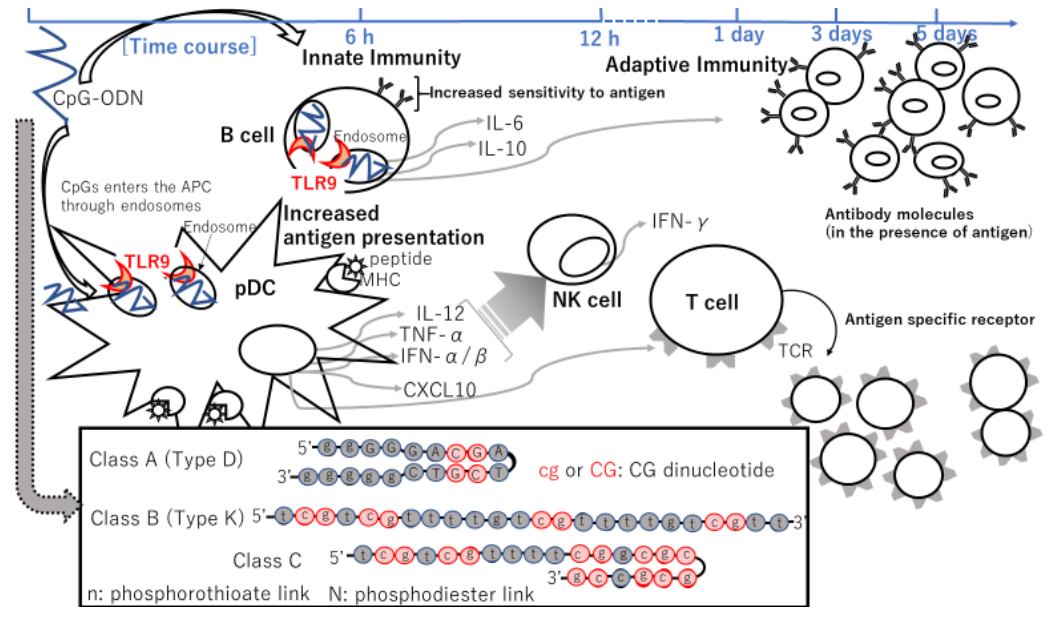
Figure 3. CpG-ODN cellular mechanism of action. DNA containing one or more CpG motifs is taken up by endocytosis in most cell types, but only activates cells expressing the TLR9 receptor (B cells and pDC in humans). These cells create a T H 1-like cytokine milieu by secreting IFN- α / β , IL-12, CXCL10, and other Th1-promoting cytokines and chemokines. NK cells are secondarily activated, secreting IFN- γ and gaining lytic activity. In addition, B cells become more sensitive to activation through their antigen receptors, and both B cells and pDCs have enhanced expression of costimulatory molecules, improving their ability to activate T-cell responses. Class A (also called Type D) ODNs have a phosphodiester core flanked by phosphorothioate terminal nucleotides (in box ). They carry a single CpG (indicated in red circles) motif flanked by a palindromic sequence that enables the formation of a stem-loop structure. Class A ODN also possesses poly G motifs at the 3 ′ and 5 ′ ends that promote concatamer formation. Class A ODNs initiate pDC to mature and secrete IFN- α but have no effect on B cells. Class A ODNs are kept for longer periods in the early endosome. Class B (also referred to as Type K) ODNs contain 1–5 CpG motifs (in red circles) typically on a phosphorothioate backbone. Class B ODNs trigger pDC to differentiate and produce TNF- α and stimulate B cells to proliferate and secrete IgM. Class B ODNs are rapidly transported through early endosomes into late endosomes. This backbone augments resistance to nuclease digestion. Class C ODNs resemble Class B ODNs in being comprised completely of phosphorothioate nucleotides but are similar to Class A ODNs in including palindromic CpG motifs that can form stem-loop conformation or dimers. Class C ODNs provoke B cells to produce IL-6 and pDCs to secrete IFN- α . Class C ODNs keep activity in both early and late endosomes, and therefore have characteristics in common with both Class A and Class B ODNs. APC, antigen-presenting cell; CpG-ODNs, CpG oligodeoxynucleotides; CXCL10, C-X-C motif chemokine ligand 10; IP-10, IFN-gamma-inducible protein of 10 kilodalton; pDCs, plasmacytoid dendritic cells; MHC, major histocompatibility complex; NK, natural killer; TCR, T-cell receptor; TLR9, Toll-like receptor 9.